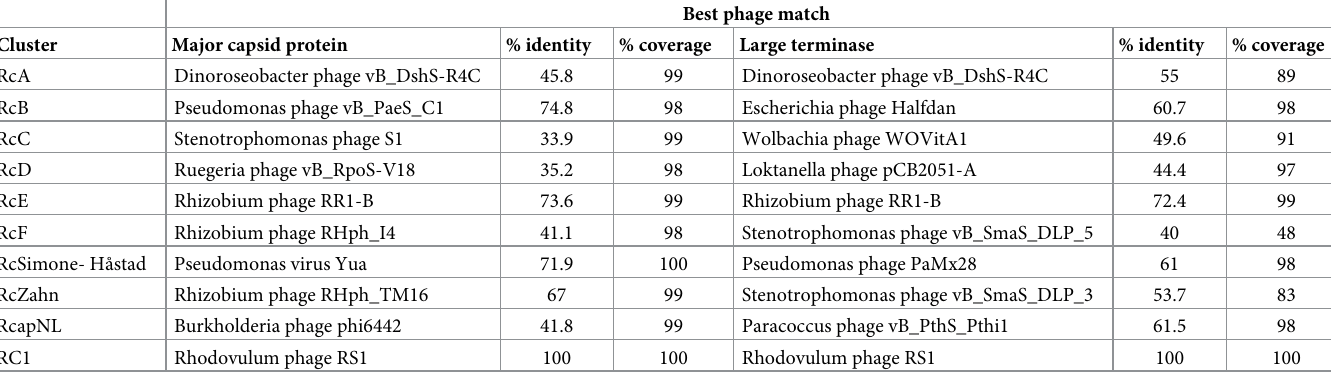
Table 4. Major capsid protein and large terminase subunit Genbank closest matches.